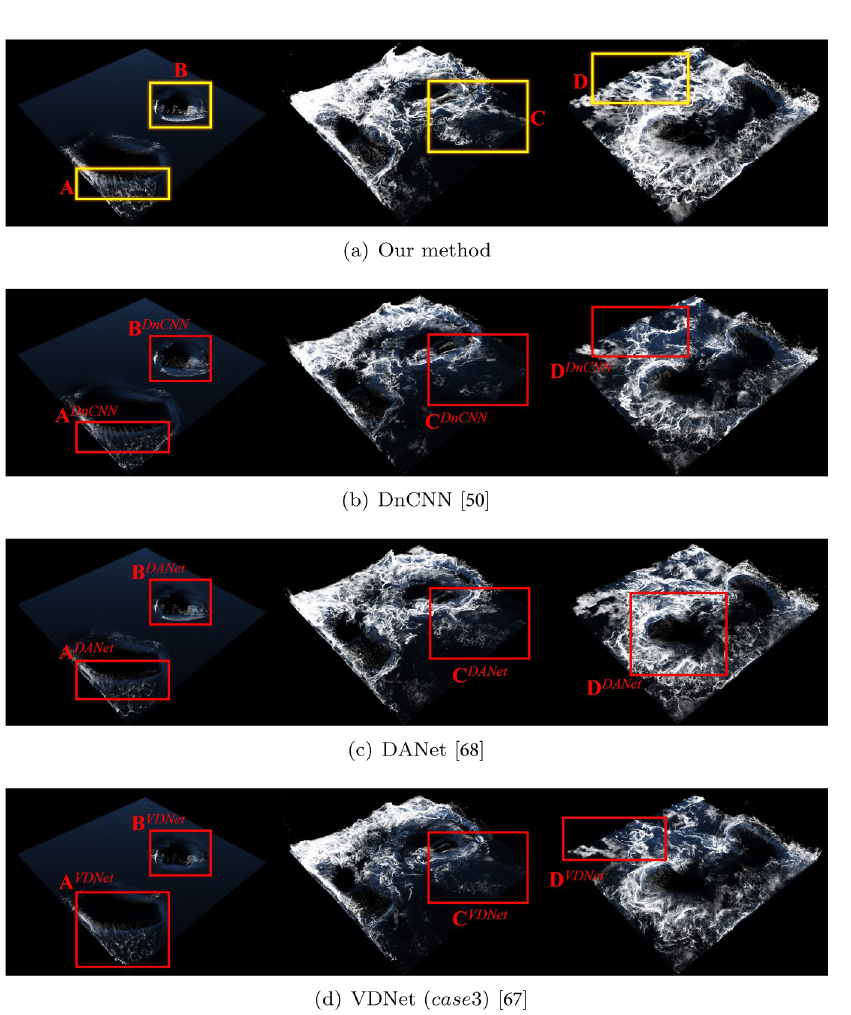
Fig 21. Comparison results with our method and previous approaches ( scene: Rotating two boxes in water ). (a) Our method, (b) DnCNN [50], (c) DANet [68], (d) VDNet (case3) [67].